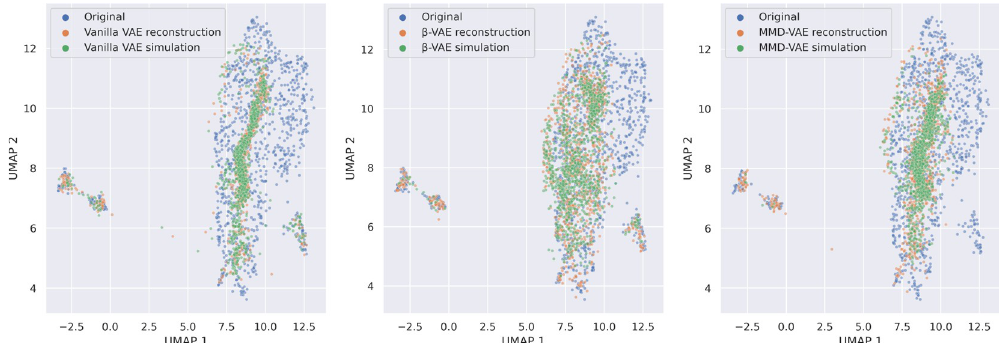
Fig 2. Two-dimensional UMAP embeddings of original, reconstruction, and simulated data for Cell Painting level 5 consensus signatures in the test set. We fit UMAP using only the original test set data and transformed the reconstructed and simulated data into this space. We simulated data by sampling from a unit Gaussian with the same dimensions as the latent space, using the same number of points as samples in the test set.